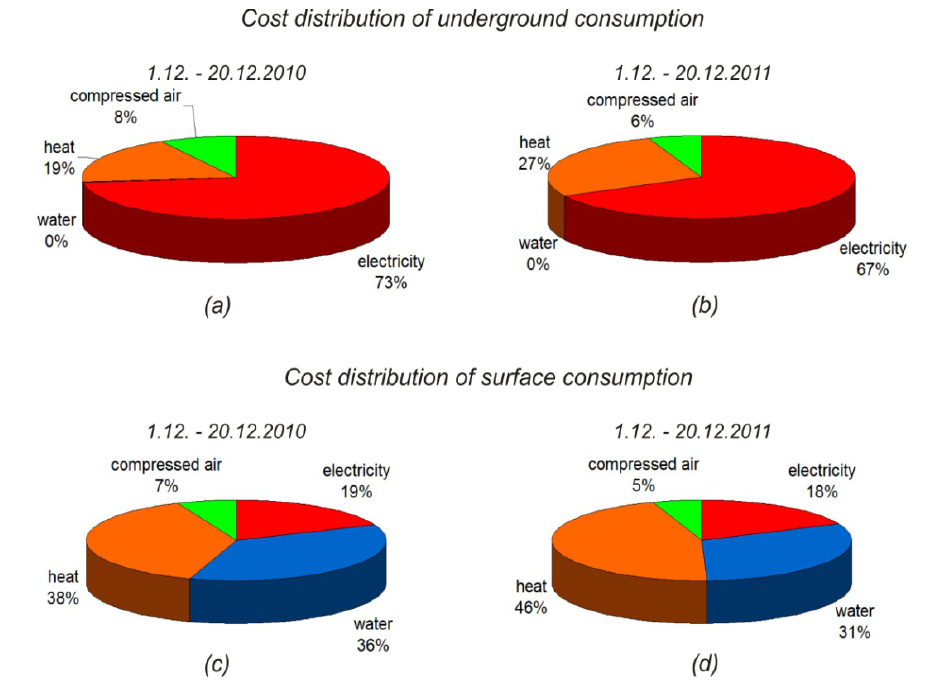
Figure 6. Cost distribution of energy consumption for the period from 1 to 20 December: ( a ) in underground mining processes in 2010; ( b ) in underground mining processes in 2011; ( c ) on surface processes in 2010; ( d ) on surface processes in 2011.